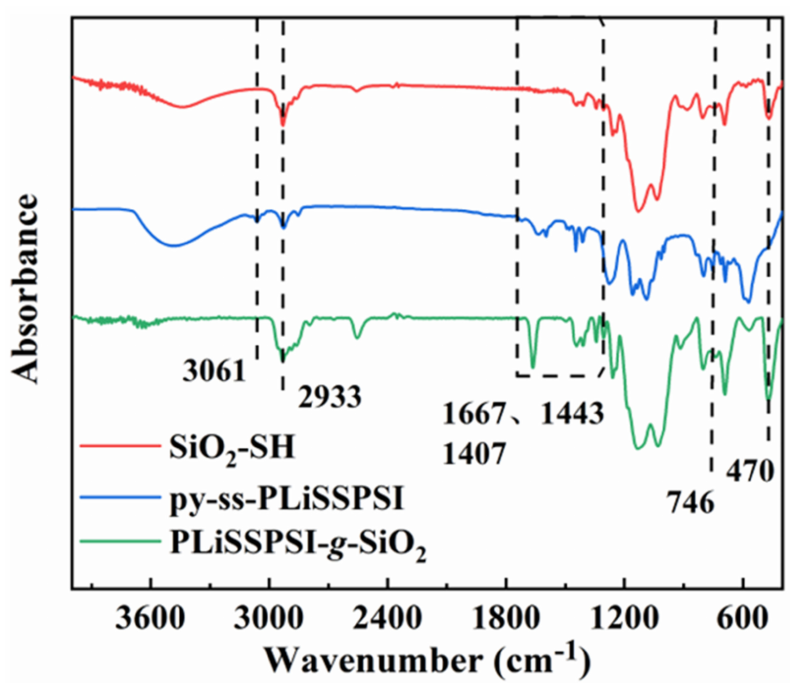
Figure 2. FTIR spectra of SiO 2 -SH, py-ss-PLiSSPSI and PLiSSPSI- g -SiO 2